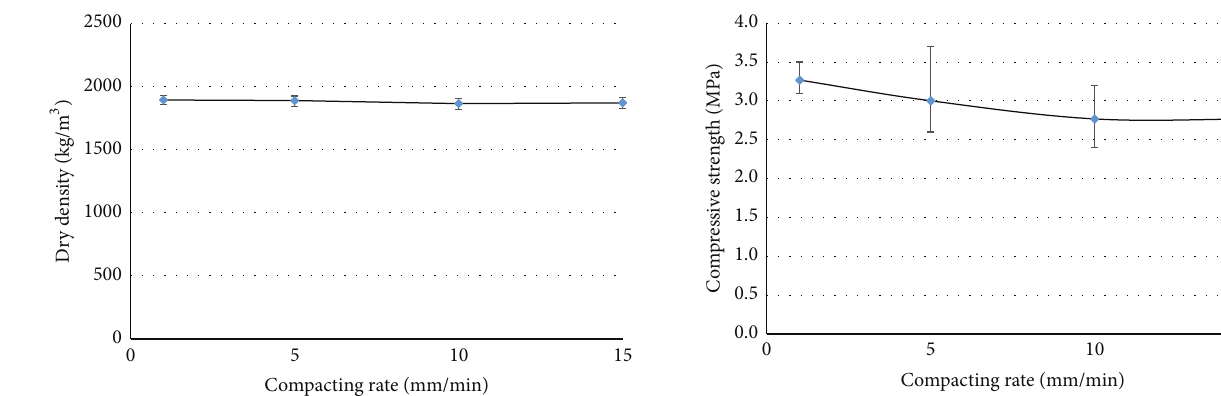
Figure 7: Dry density of compressed earth blocks (error bars represent range of data obtained) .